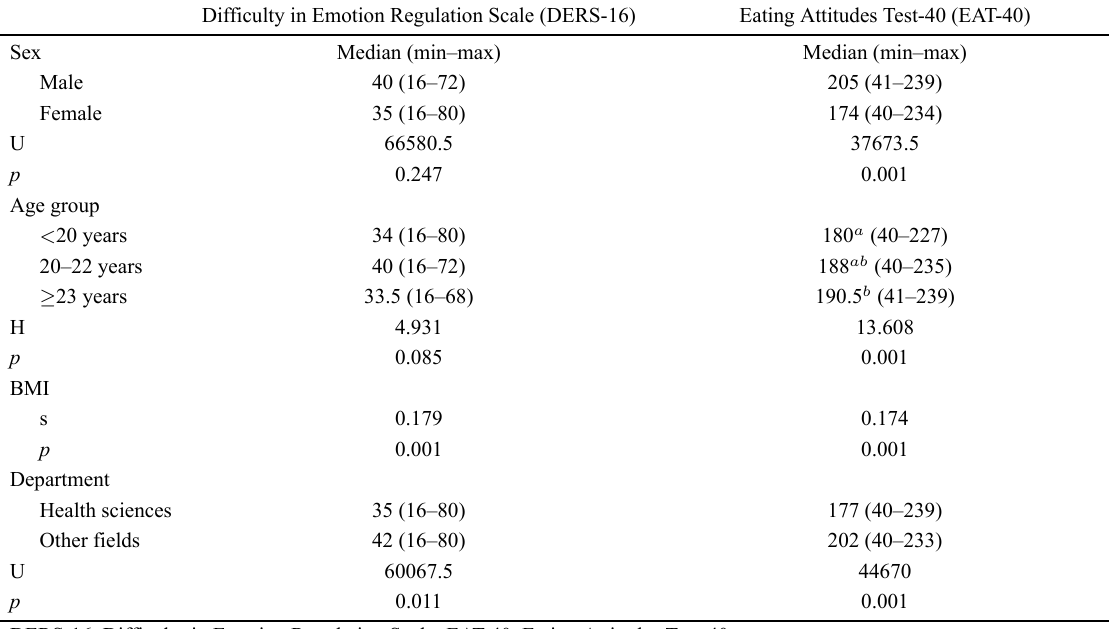
Table 2. Comparison of DERS-16 and EAT-40 scores of participating university students according to demographic and nutritional findings.